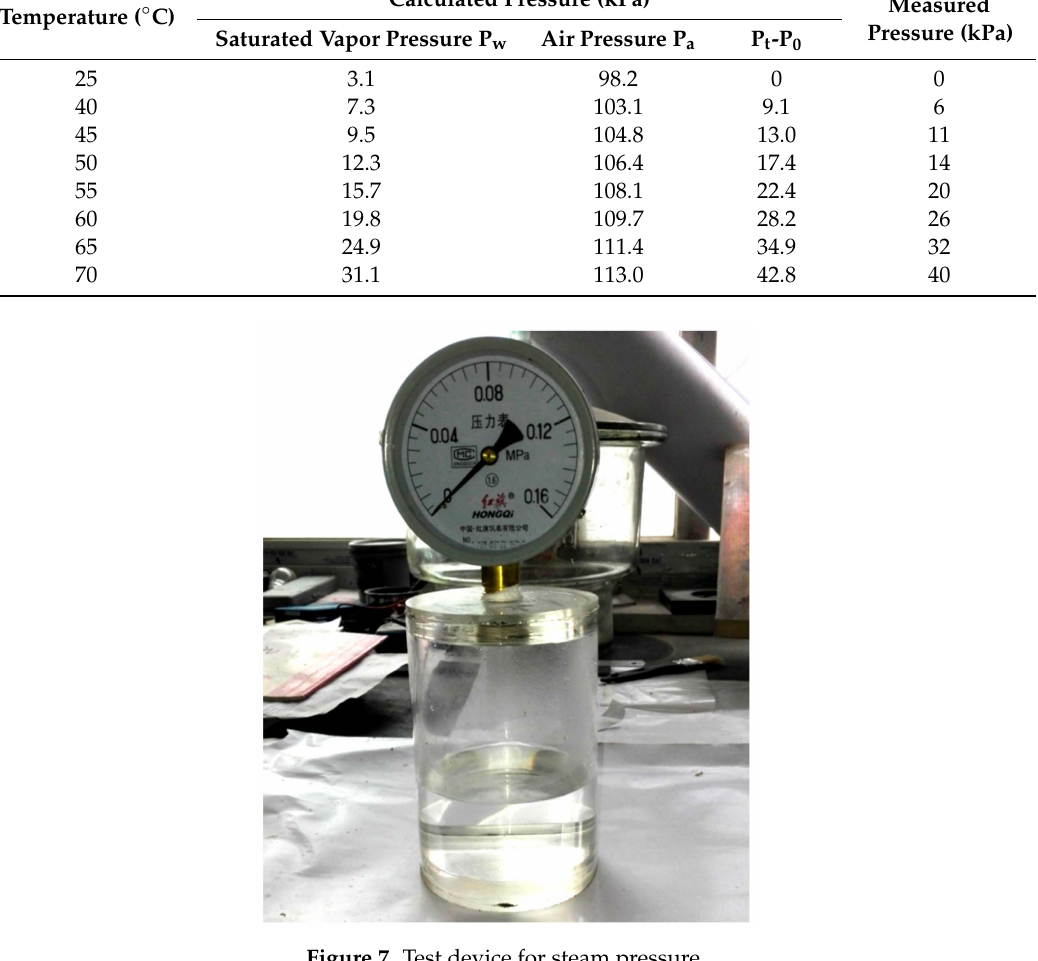
Figure 7. Test device for steam